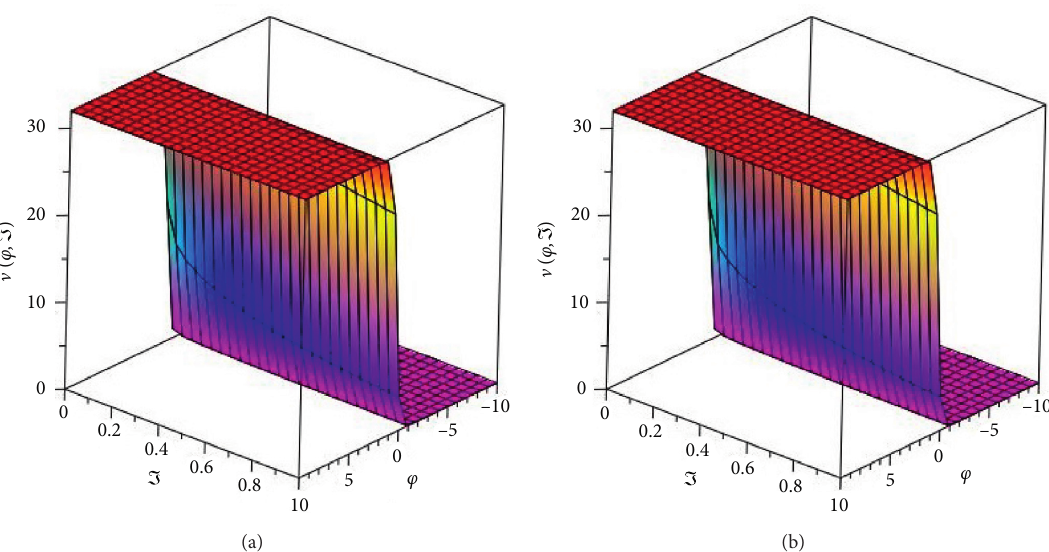
Figure 2: The exact and analytical solution with respect to the Caputo–Fabrizio operator of ] ( φ , I ) at β � 1 of Example